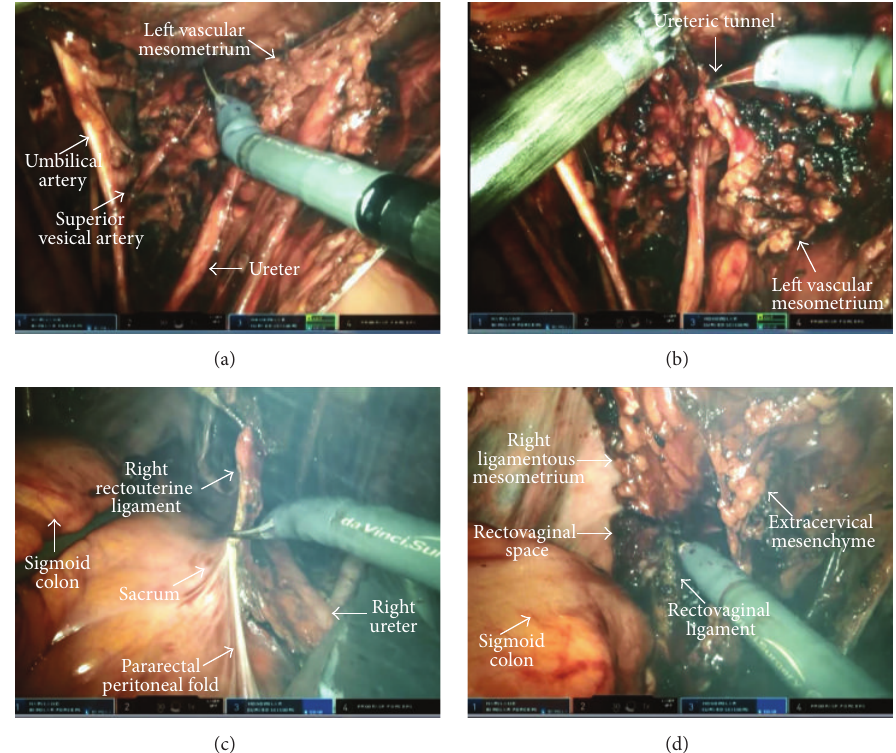
Figure3:((a),(b))Resectionoftheanteriorpartofthevascularmesometrium(leftside).((c),(d))Resectionoftheligamentousmesometrium (right